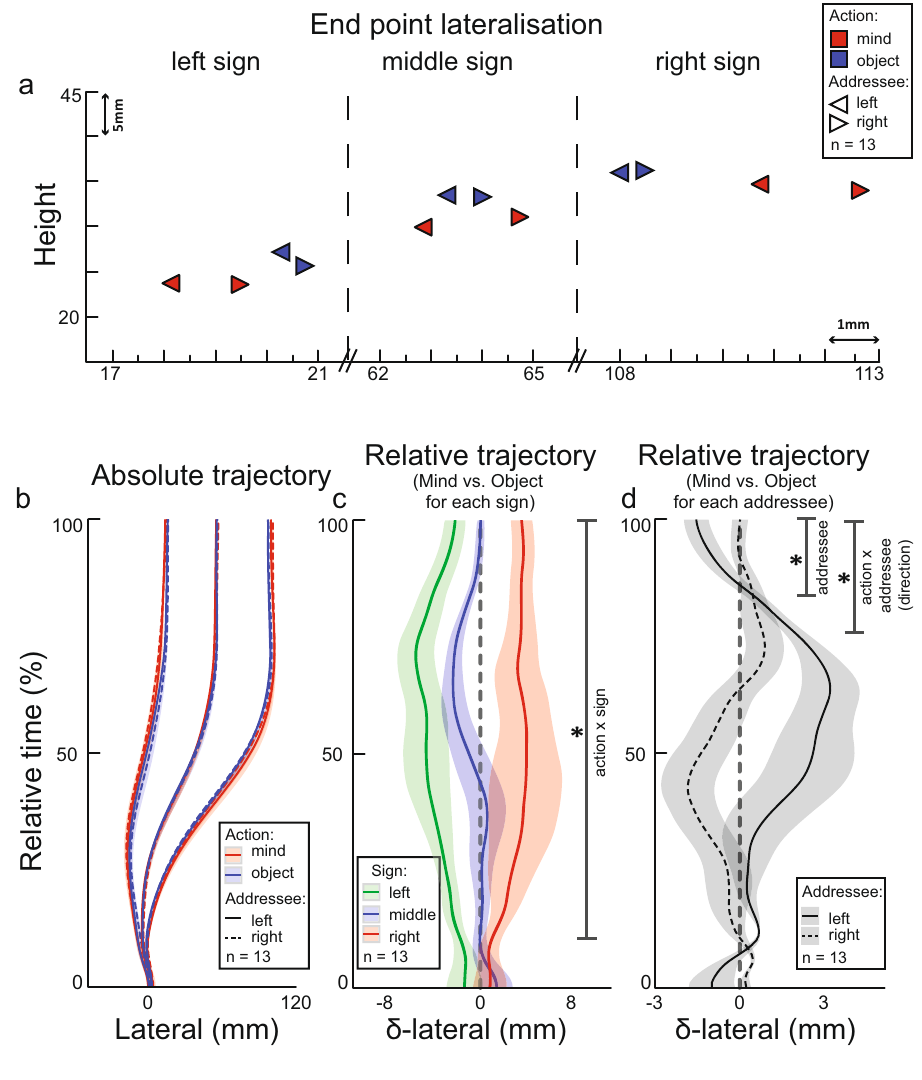
Figure 3. End point locations and lateral development of the trajectory dynamics. ( a ) Pointing end locations towards the left, middle and right signs projected on the horizontal-altitude plane, split for mind- and object oriented actions (red and blue, respectively) and left and right addressees (indicated by arrows). ( b ) Temporal development, relative to the forward movement time, of the horizontal displacement of pointing movements (the ‘lateral development’), split for left, middle and right signs, mind- and object oriented actions (red and blue, respectively) and left and right addressees (continuous lines and dashed lines, respectively). ( c ) The relative difference in the lateral development between mind-oriented and object-oriented pointing movements, split for the left, middle and right signs (green, blue, and red, respectively). * Indicates a significant action x sign interaction from 10–100% ( p < 0.05, corrected). ( d ) The relative difference in the lateral development of mind-oriented and object-oriented pointing movements for the left and right addressee positions. * Indicates a significant addressee effect from 83–100% and an action x addressee interaction effect in direction (lateral velocity) from 75–99% (both p < 0.05, corrected). Variance clouds around the mean trajectories represent standard errors of the mean. The grey dashed lines at point 0 of the relative lateral deviation (in c and d ) represent the baseline object-oriented movements to which the communicative counterparts are contrasted. See the Supplemental Material for the relative lateral deviation split for each combination of sign and